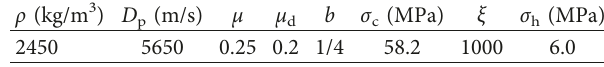
Table 4: Explosion calculating parameters for rock.